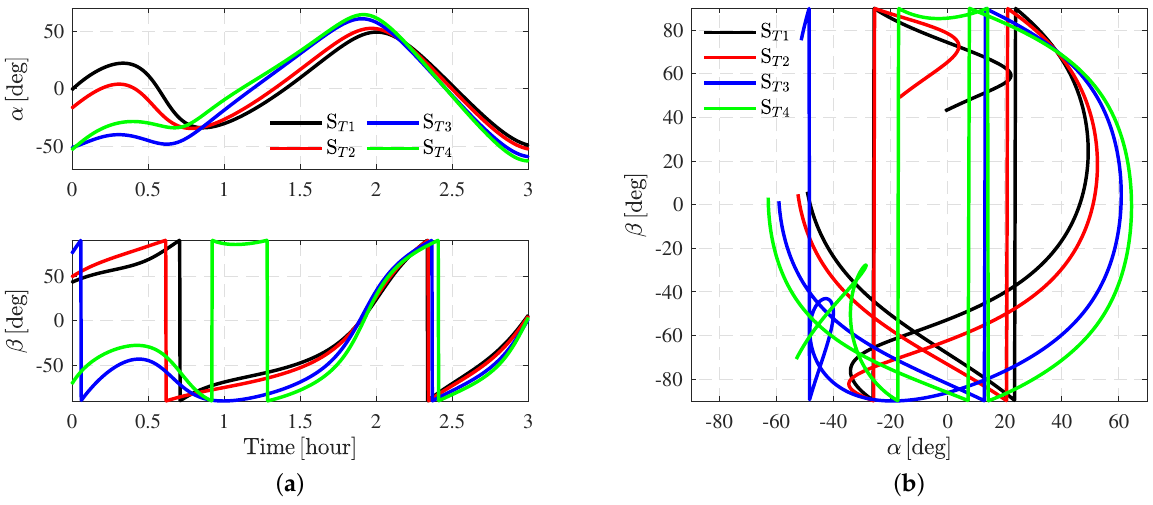
Figure 4. The nominal angular measurements. ( a ) time history of the two angular measurements; ( b ) projection of the two angular